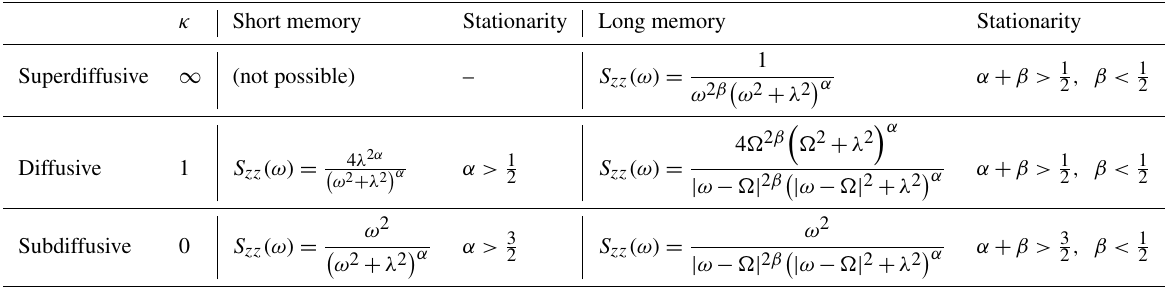
Table C1. Examples of spectra for short- and long-memory processes of subdiffusive, diffusive, and superdiffusive types. The term in the box is the spectrum of the Matérn process, as given in Eq. (39). Note that the two spectra corresponding to diffusive processes have been normalized such that κ = S zz ( 0 )/ 4 = 1. λ is a nonnegative constant, while (cid:127) is here a nonzero constant of either sign. κ Short memory Stationarity Long memory Stationarity